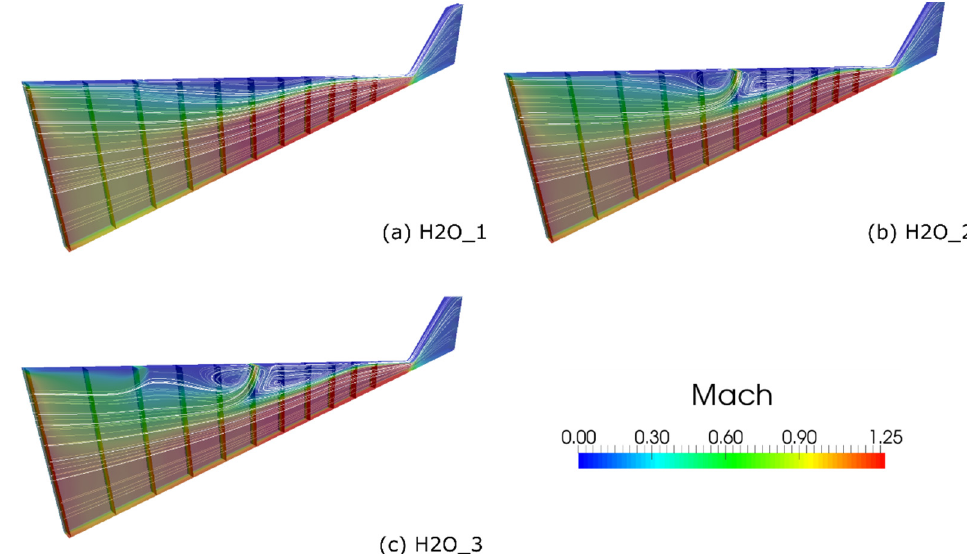
Figure 7. 3D representation of the water vapor flow into the micro-nozzle through contour plot of the Mach number in combination with streamline visualization: ( a ) test case H2O_1 (baseline); ( b ) test case H2O_2 (additional mass flow rate with jet 1 = ON, jet 2 = OFF); ( c ) test case H2O_3 (additional mass flow rate with jet 1 = ON, jet 2 = ON).